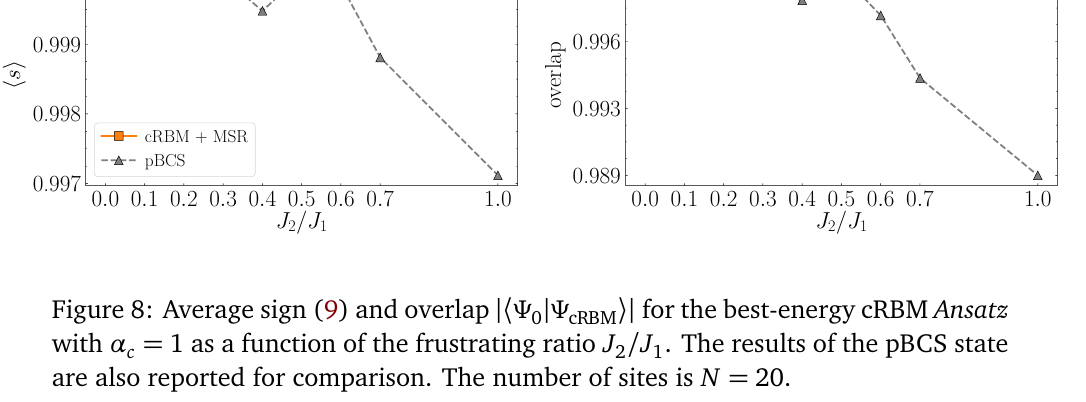
Figure 8: Average sign (9) and overlap |〈 Ψ = 1 as a function of the frustrating ratio J with α c are also reported for comparison. The number of sites is N =